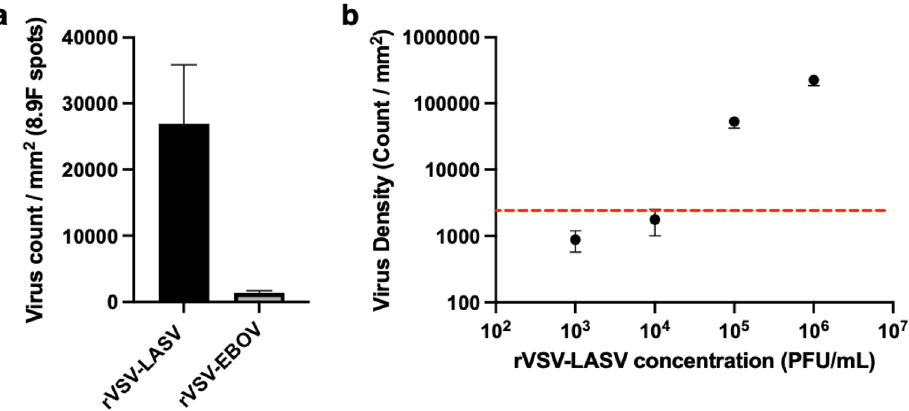
Figure 5. Specificity and sensitivity of 8.9F antibody for rVSV-LASV detection. ( a ) 8.9F antibody specificity test. Average virus densities on 8.9F spots (n = 6 spots) obtained from SP-IRIS images of two different chips incubated with either rVSV-LASV or rVSV-EBOV, both at a concentration of 5 × 10 4 PFU/mL. 8.9F antibody binds to rVSV-LASV whereas it does not show any significant binding for rVSV-EBOV chip. ( b ) Dilution series experiment for rVSV-LASV detection in FBS using 8.9F as the capture antibody (n = 6 spots). The lowest concentration detected is 10 5 PFU/mL, however, actual LOD is closer to 10 4 PFU/mL. Red dashed line represents the detection threshold obtained from 8.9F spots on a chip incubated with FBS alone and calculated as mean virus density plus three standard deviations. LOD experiment was performed at least three times in independent experiments.